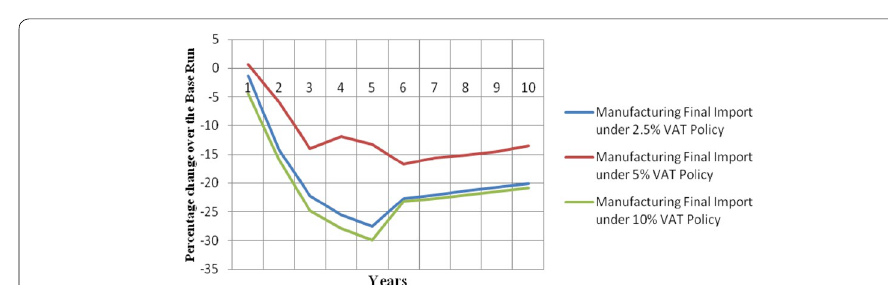
Fig. 36 Changes in manufacturing final imports under varying VAT rates